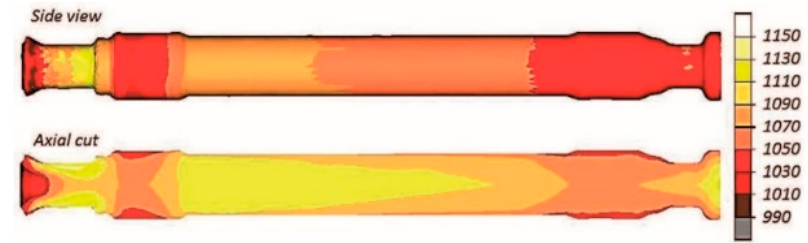
Figure 15. Distribution of temperature field in the three-roll skew rolling rail axle [16] (Reprinted from ref. [16]).